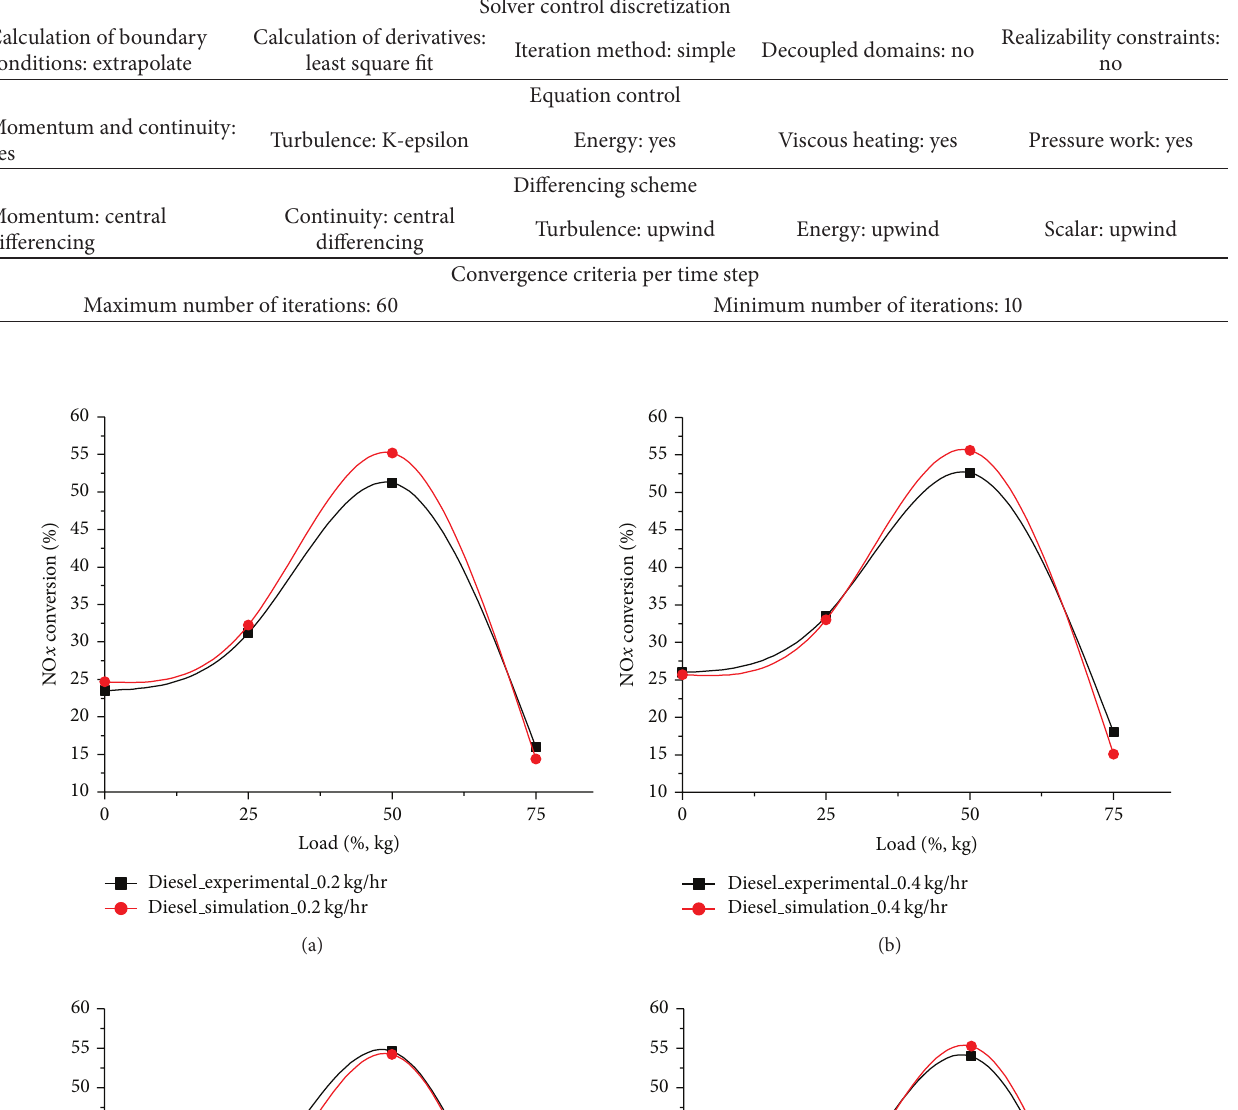
Table 2: Boundary conditions used in the simulation work. Solver control discretization